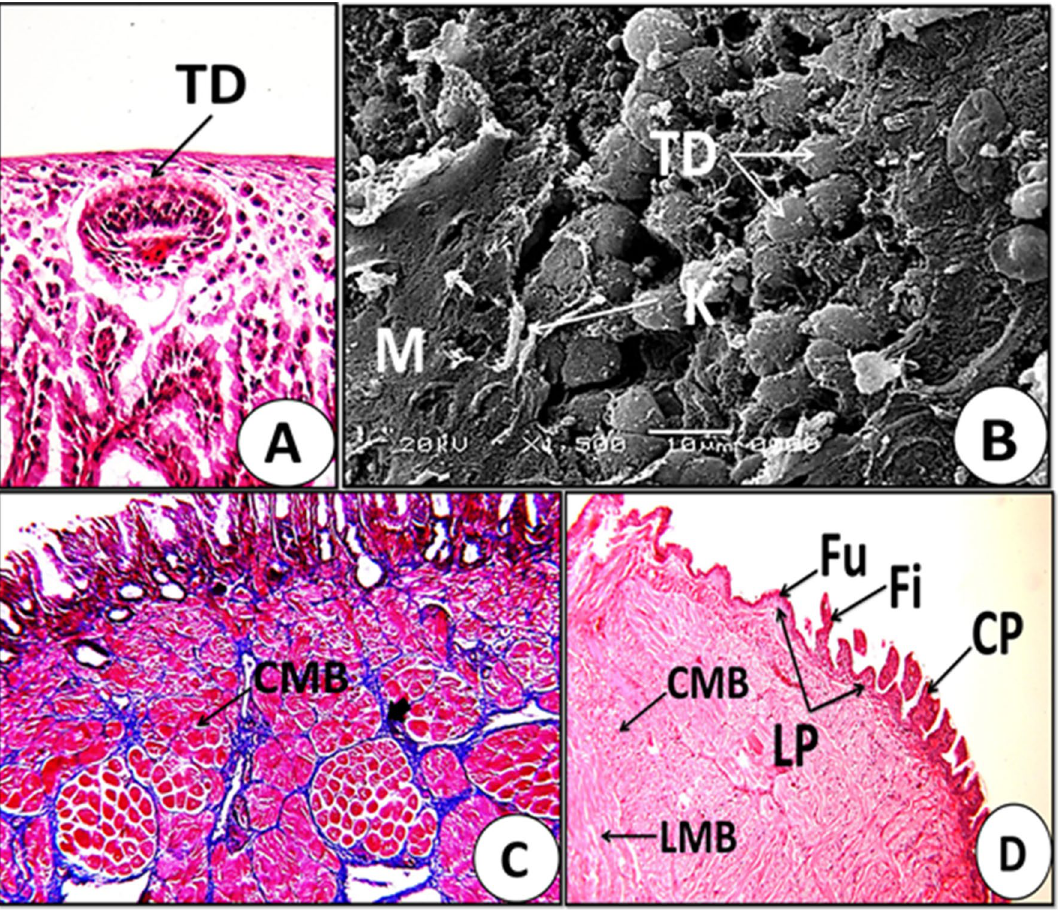
Fig. 2 A A photomicrograph of a longitudinal section of the posterior region of the tongue of Ptychadena mascareniensis stained with H & E showing taste disk (TD), X 400; B scanning electron micrograph of the dorsal surface of the posterior region of the tongue of P. mascareniensis showing mucosa (M), keratinization (K) and taste disks (TD), Scale bar 10 µm, X 1.500; C a photomicrograph of a longitudinal section of the middle region of the tongue of Ptychadena mascareniensis stained with Mallory’s triple stain showing the collagen content presented in dark blue color (arrow) surrounds the circular muscle bundles (CMB), X 100; D a photomicrograph of a longitudinal section of the anterior region of the tongue of Hemidactylus turcicus stained with H & E showing fungiform (Fu), filiform (Fi), cuboid papillae (CP), lamina propria (LP), circular muscle bundles (CMB) and longitudinal muscle bundles (LMB), X